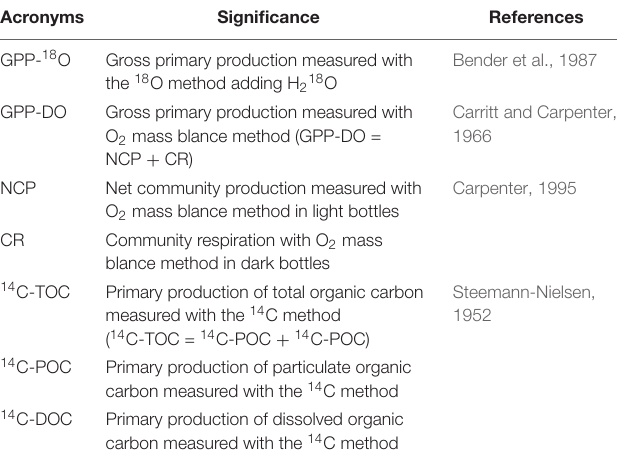
TABLE 1 | Acronyms for primary production variables used in this study, including their definition and